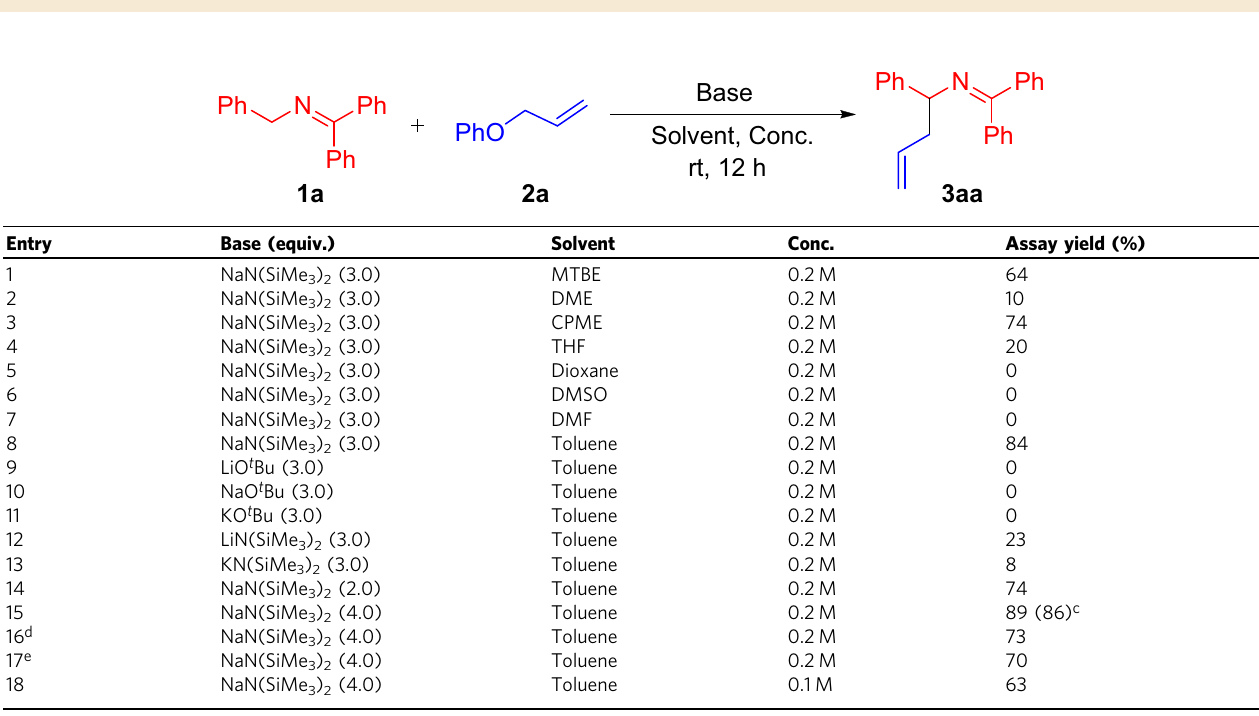
Table 1 Optimization of coupling of ketimine 1a and allyl phenyl ether 2a a,b .